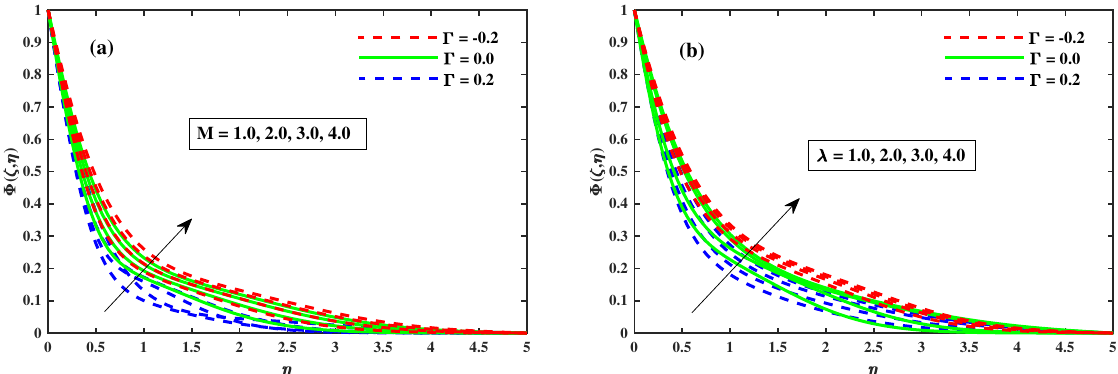
Figure 12. Variation in Φ ( ζ , η ) for M in ( a ) and for λ in ( b ) when ζ =